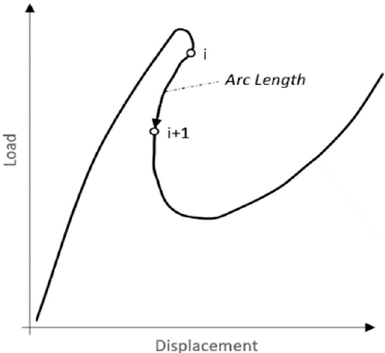
Figure 2. Arc-Length increment displayed in a typical force–displacement curve.